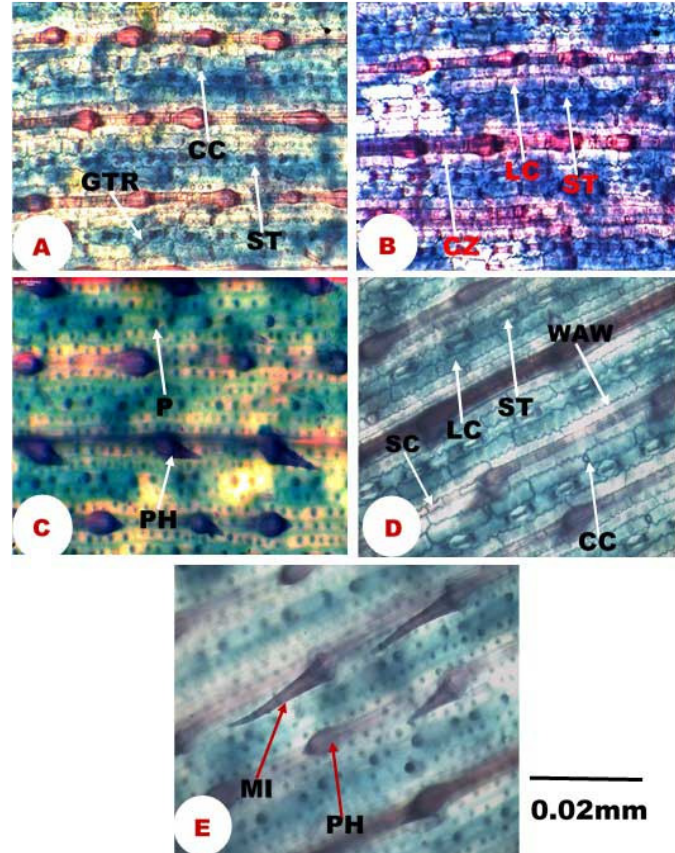
Plate 5A – E. Epidermal features of the abaxial surfaces of A. tectorum accessions A, AT6 showing costal prickles with 3 intercostal zones, glandular trichome and cork cell; B, AT4 showing costal prickles with rows of stomata on intercostal zones; C, AT1 showing costal prickles and papillae; D, AT3 showing 4 costal zones with prickle hairs and 3 intercostal zones; E, AT3 showing microhairs and Prickle hairs. CC- Cork cell, CZ- Costal zone, GTR – Glandular trichome, LC- Long cell, MI- Microhair, P – Papillae, PH- Prickle Hair, SC- Short cell, ST – Stomata, WAW – Wavy anticlinal wall Adaxial surface (Plates 6A - D) The anticlinal wall is wavy as shown in Plate